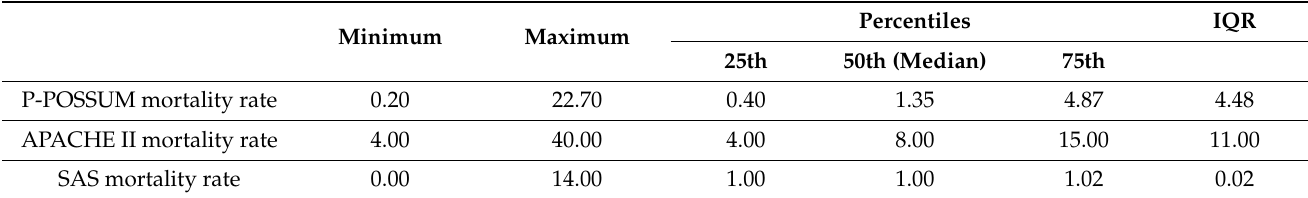
Table 2. Estimated mortality of P-POSSUM, APACHE II, and SAS.